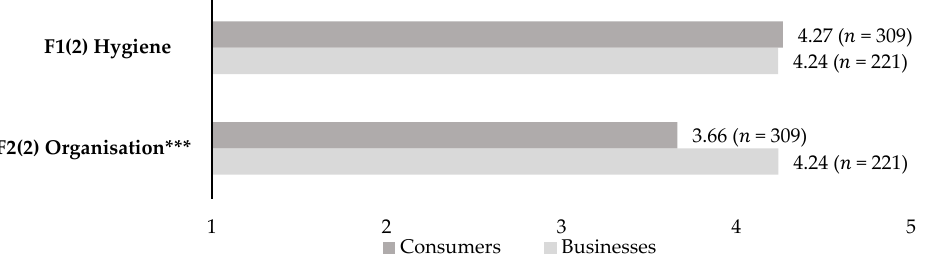
Figure 2. Imposed safety measures: consumers’ attitudes vs. perceived impact on businesses’ profitability. Note: *** p < 0.001; FX(Y) with X = number of factor, Y = number of study.